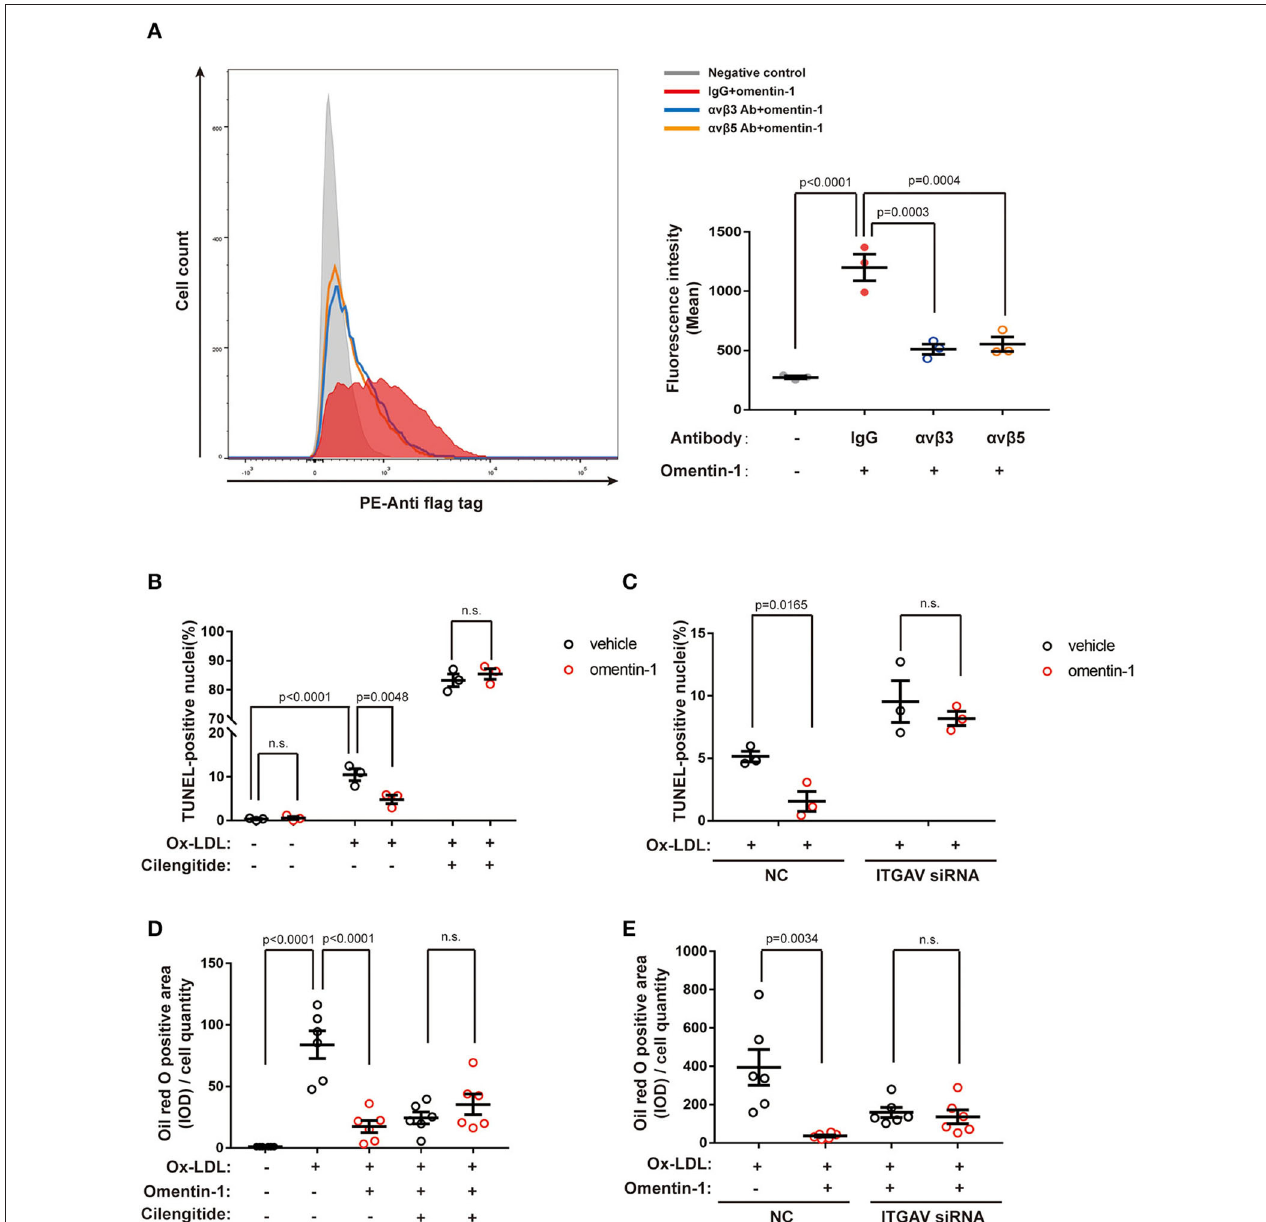
FIGURE 5 | Neutralizing the antibody against the integrin receptor reduced omentin-1 binding to the cell membrane. Omentin-1 attenuated the apoptosis and lipid burden induced by ox-low-density lipoprotein (LDL) in macrophages. (A) THP1 cells were induced by 100ng/ml PMA for 48h to transform into a macrophage phenotype. After being pretreated by the IgG isotype or neutralizing antibodies against human integrin α v β 3 or α v β 5, the cells were then incubated with Flag-tagged omentin-1. The retention of omentin-1 on the cell membrane was detected by the antibody against the flag tag (PE-labeled). The mean intensity of PE fluorescence was quantified and used to express the magnitude of omentin-1 retention ( n = 3). (B) The RAW264.7-derived macrophages were pretreated by omentin-1 (800ng/ml) for 1.5h, and then they were co-incubated with high ox-LDL (50 µ g/ml) for 24h. Apoptosis of macrophages was probed by an in situ cell death detection kit (TUNEL), and the apoptotic rate was presented as the percentage of TUNEL-positive nuclei ( n = 3). (C) The RAW264.7-derived macrophages were transfected by ITGAV siRNA to knock down the expression of ITGAV. Then they were incubated with omentin-1 and high ox-LDL to induce apoptosis. The apoptotic rate was assessed as described above ( n = 3). (D) The RAW264.7-derived macrophages were pretreated by omentin-1 (900ng/ml) for 1.5h, and then they were co-incubated with mild ox-LDL (50 µ g/ml) for 24h. The lipid content of the cells was detected by an oil red o stain kit. The integral optical density (IOD) of the oil red o positive area vs. cell counts was calculated to represent the lipid retention in cells ( n = 6). (E) The RAW264.7-derived macrophages were transfected by ITGAV siRNA to knock down the expression of ITGAV. Then they were incubated with omentin-1 and mild ox-LDL to induce apoptosis. The lipid retention of cells was assessed as described above ( n = 6). All data in this figure were presented as mean ± SEM (n.s., non-significant).